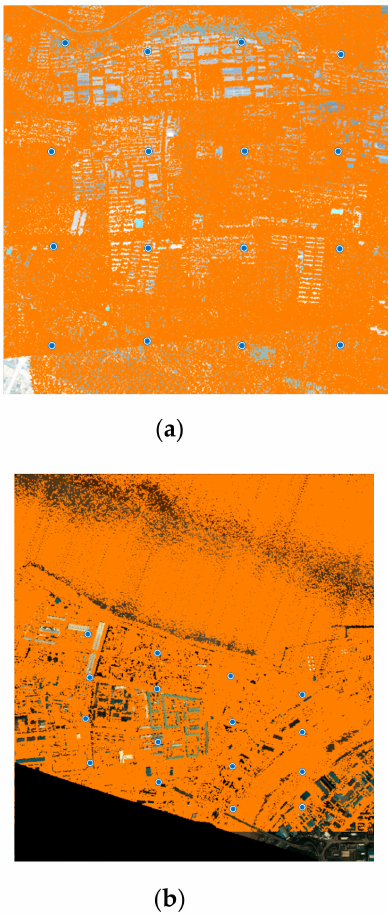
Figure 10. Virtual control points (16 selected VCPs): ( a ) Dataset 1; and ( b ) Dataset